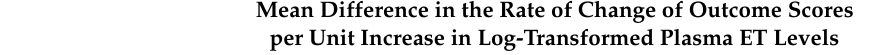
Table 3. Effects of baseline plasma ET on CDR-SOB progression and global/domain-specific cognitive